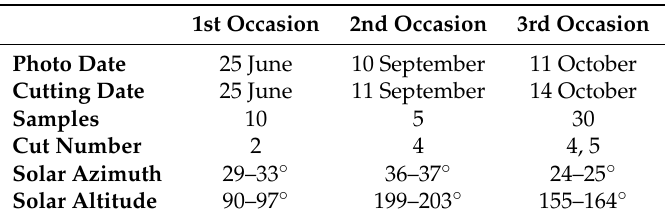
Table 1. Photograph and cutting dates, number of samples, cut number and solar azimuth and altitude on the photo date for each